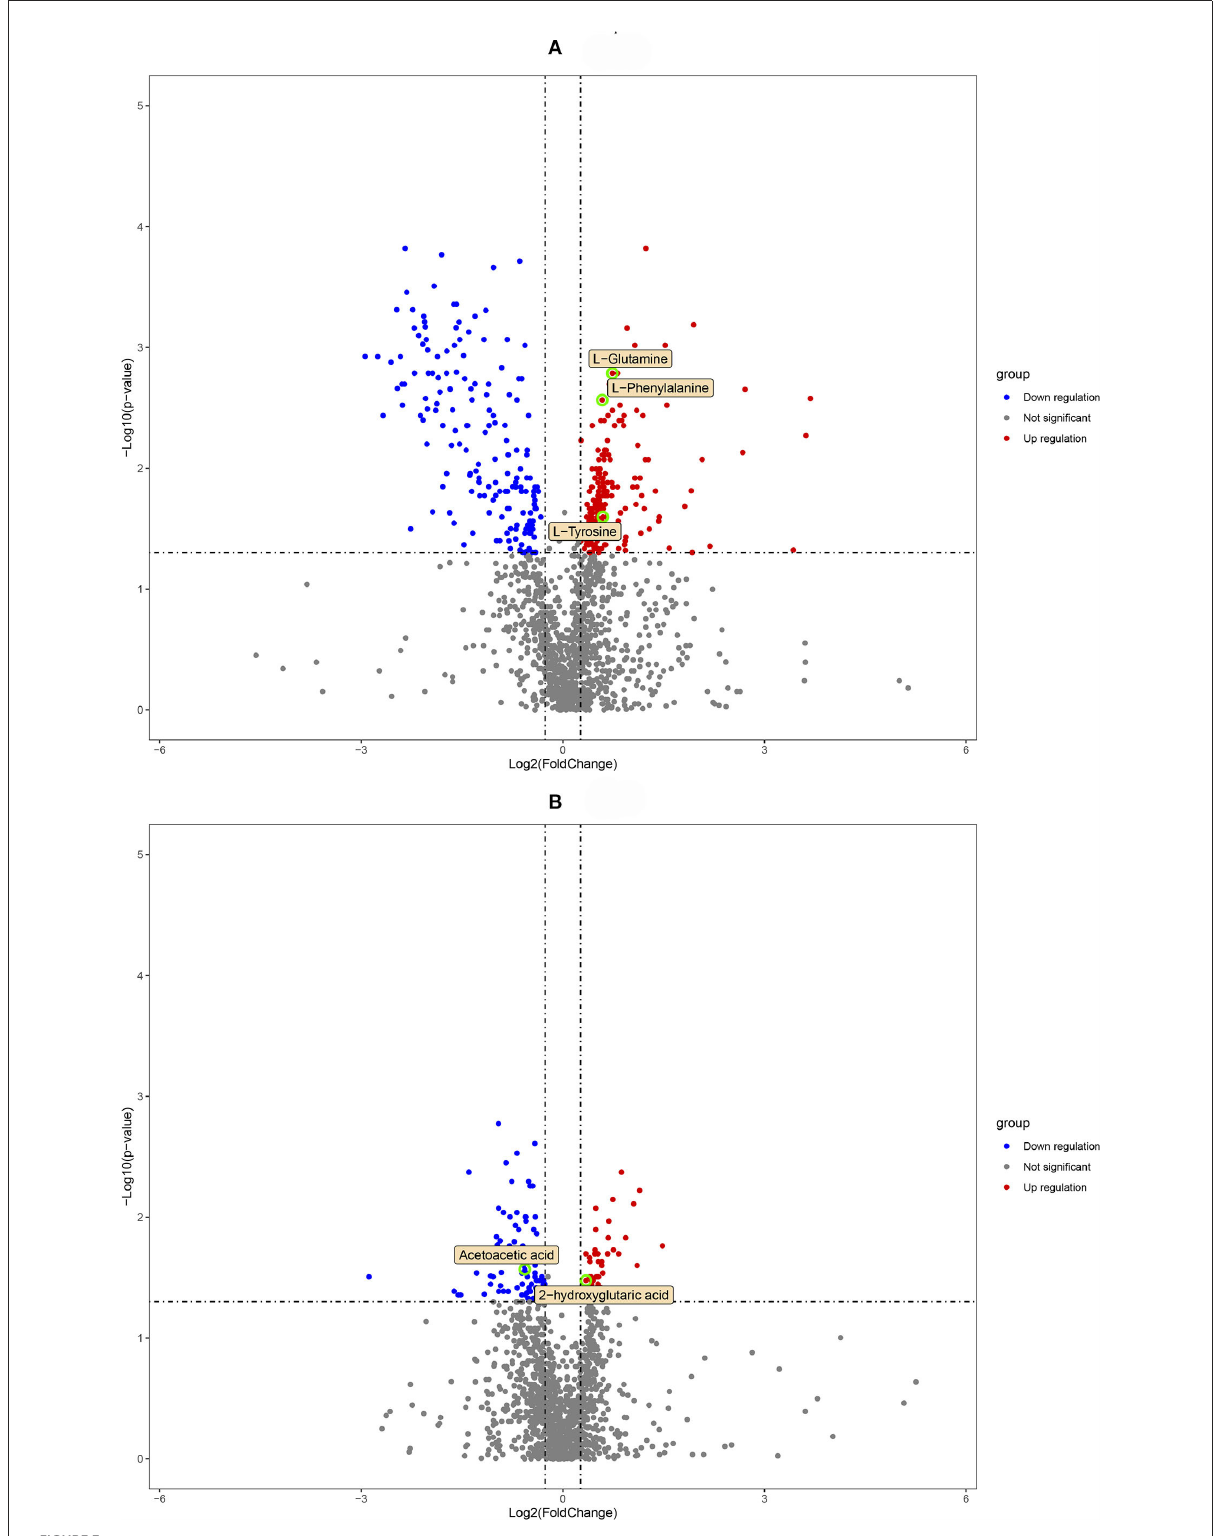
FIGURE3 (A) is the volcano plot of the environmental factor group (DUvsG), and DUvsG refers to the group “Deep-underground vs. ground”; (B) is the volcano plot of the sleep quality group (GSQvsPSQ), and GSQvsPSQ refers to the group “Good sleep quality vs. poor sleep quality.” The points circled in green are the finally defined differential metabolites of potential